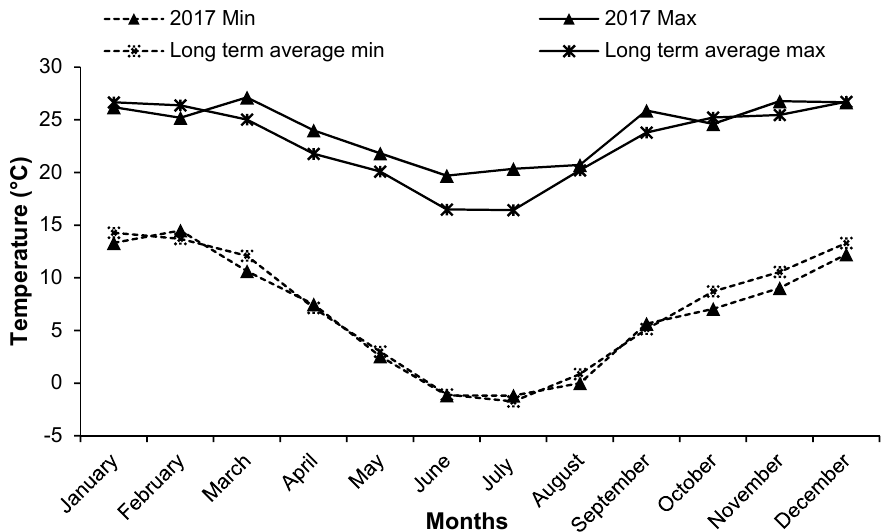
Figure 1. Temperature conditions at the Bethlehem long-term trial site. (source: Agricultural Research Council’s agro-climate database; http://155.240.219.9/agromet/Login-Screen-php?btn-Login=CON-